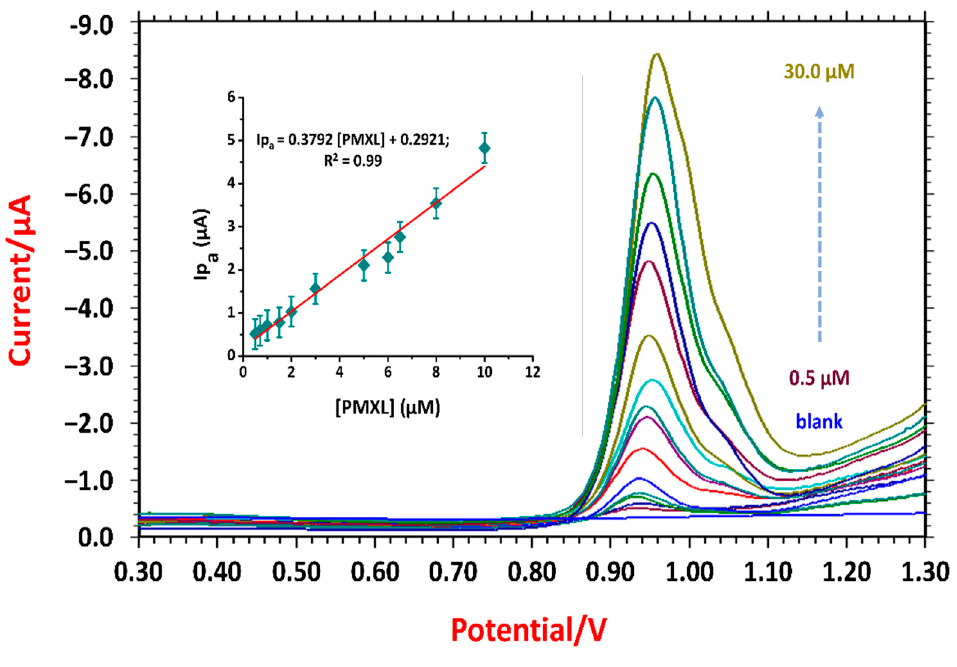
Figure 6. SWV responses of PMXL at different concentrations, at a pH of 3.02, at t imm of 40 s; ( a ) calibration curve in a tested concentration range.